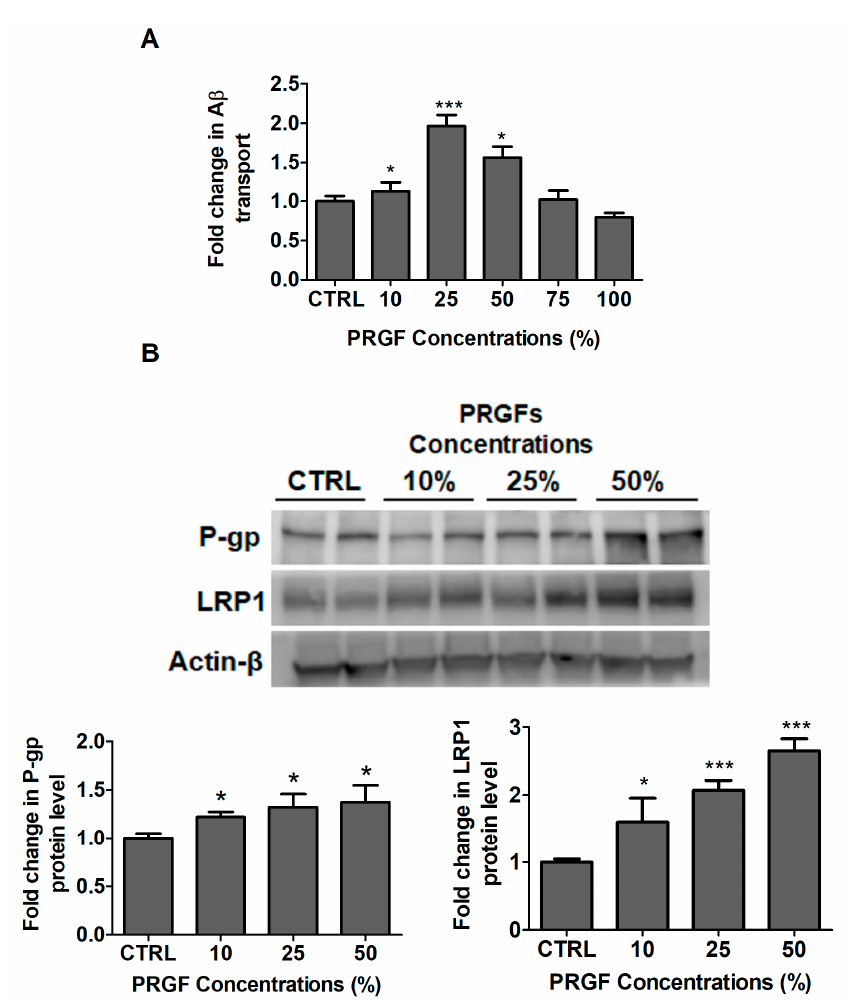
Figure 2. PRGF increased the A β 42 transport across the cell-based BBB model in-vitro. ( A ) Concentration-dependent increase in A β 42 transport across the bEnd-3 cells-based BBB model. Data represented as mean ± SD of 3 independent experiments with n=4 wells/treatment/experiment. ( B ) Representative blots and densitometry analysis of A β major transport proteins demonstrated a concentration-dependent increase of P-gp and LRP1. Data are presented as mean ± SD of three independent experiments with n = 3 dishes/treatment group/experiment. * p < 0.05, *** p < 0.001 compared to control (CTRL) group.